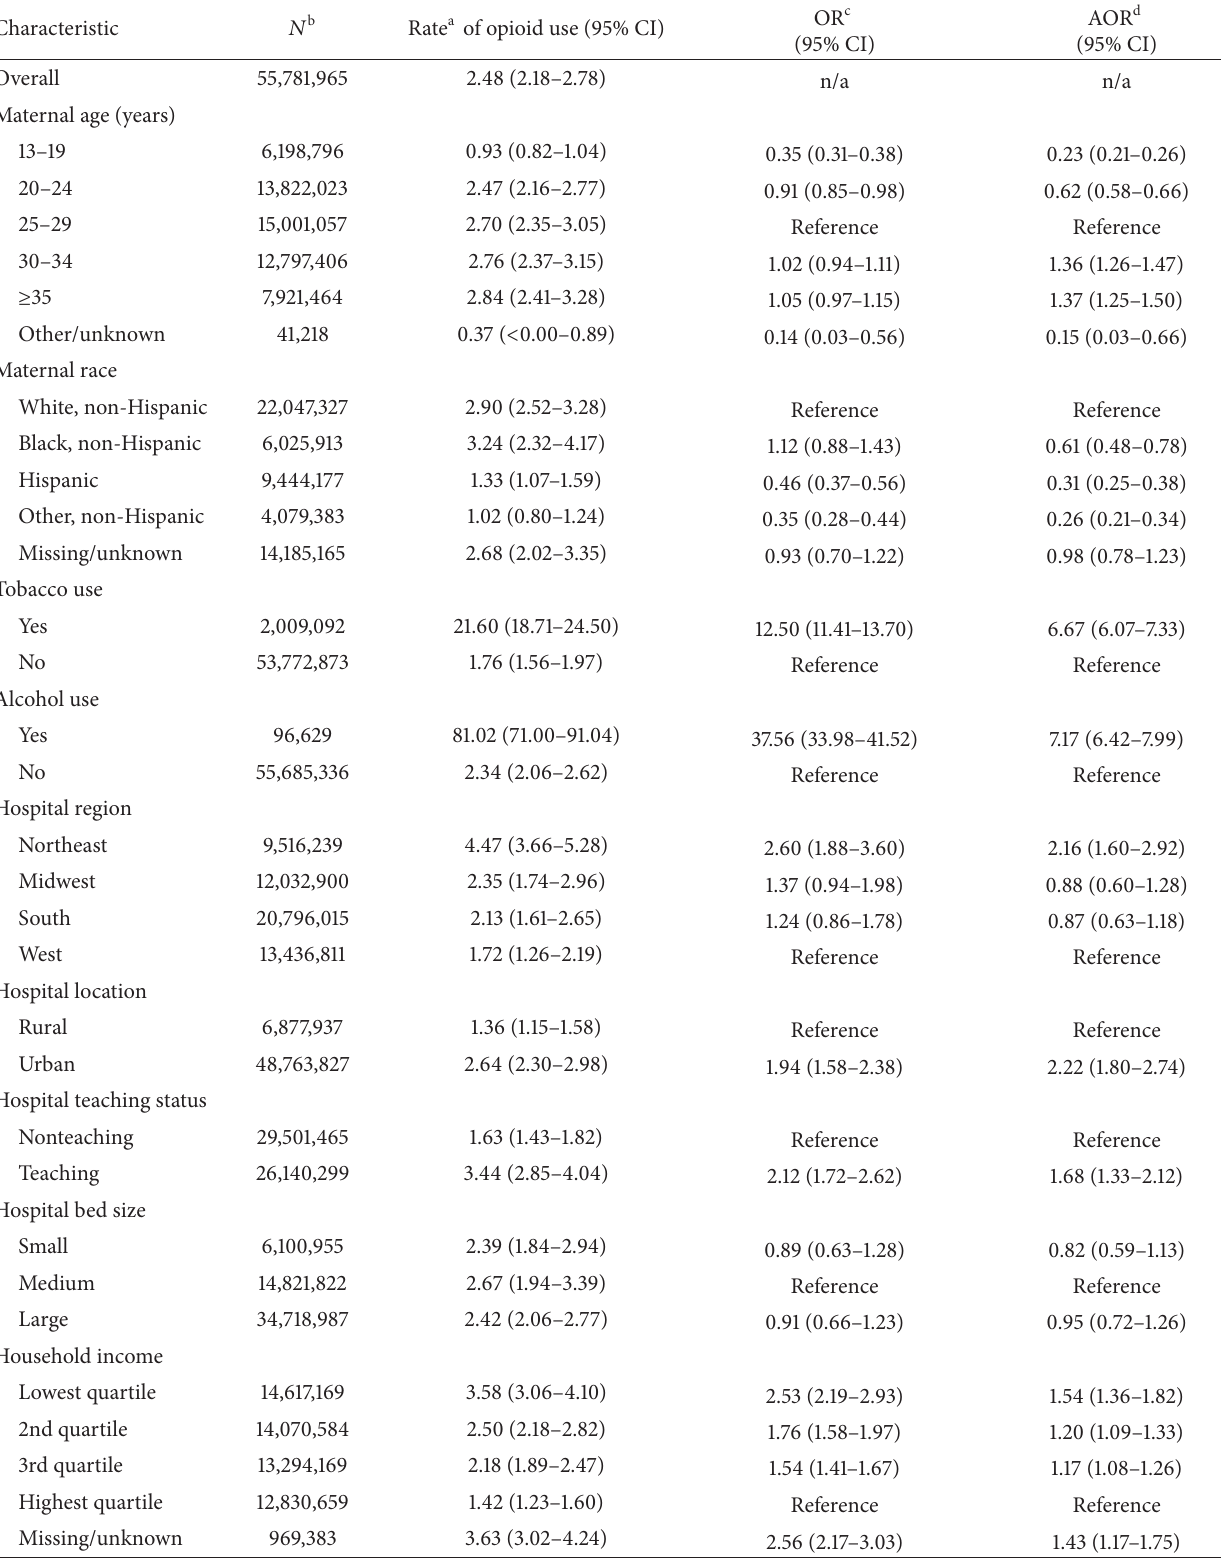
Table 1: Rates a of opioid use by maternal sociodemographic, perinatal, behavioral, and hospital characteristics, among pregnancy-related discharges, NIS,